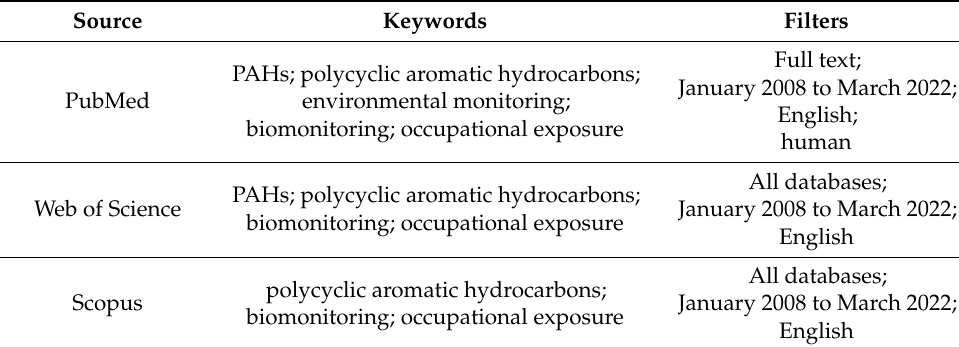
Table 1. Search terms used in the different literature databases.